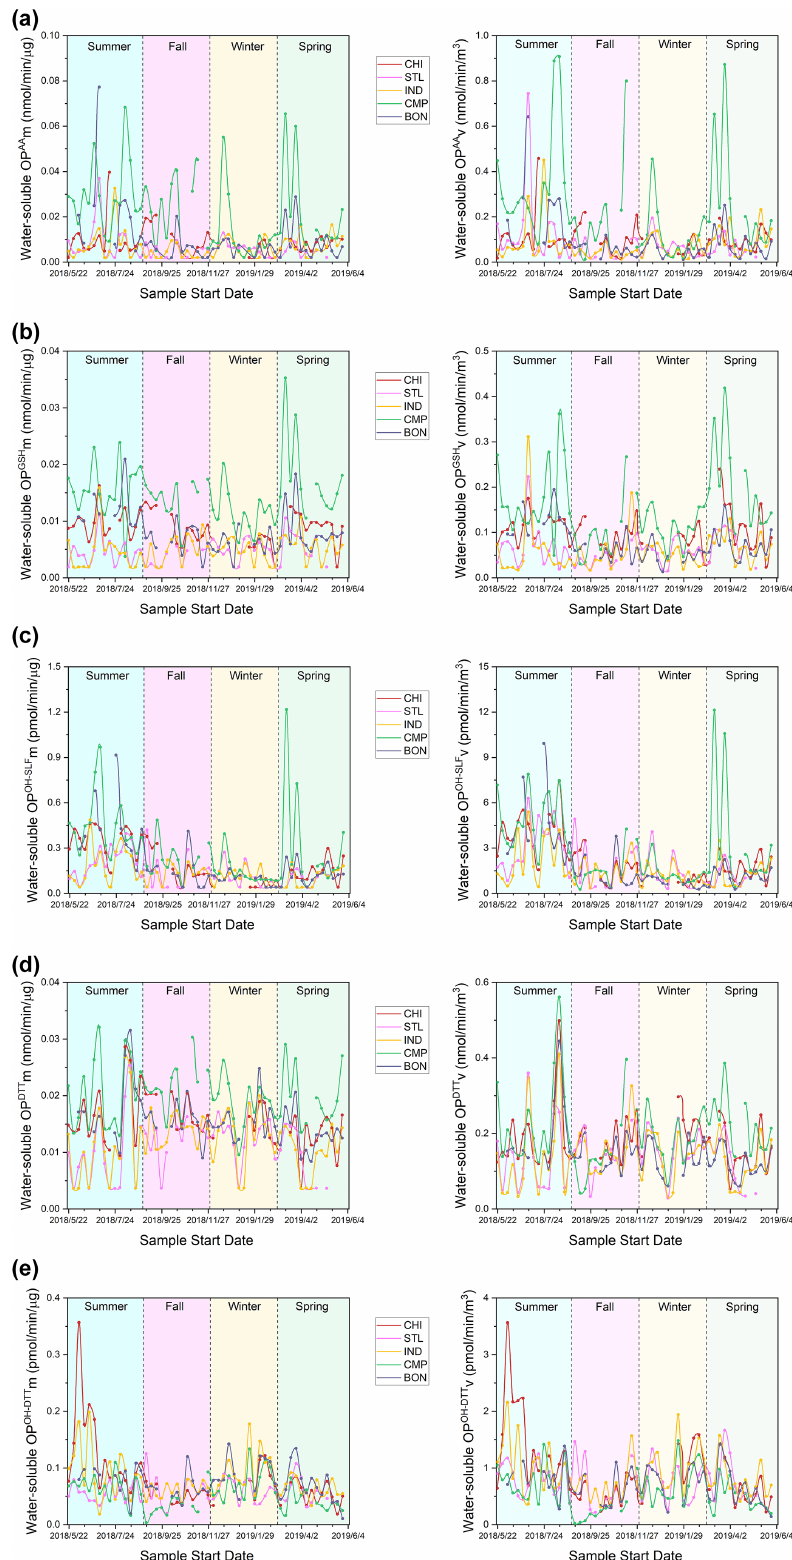
Figure 3. Time series of mass-normalized (left) and volume-normalized (right) water-soluble OP activities for (a) OP AA , (b) OP GSH , (c) OP OH − SLF , (d) OP DTT , and (e) OP OH − DTT at our sampling